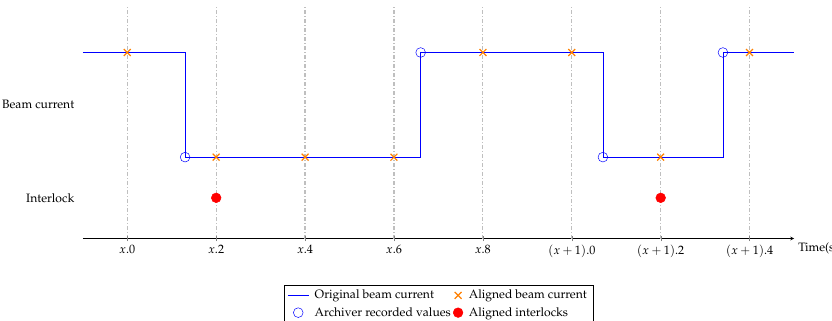
Figure 4. Synchronization of the beam current as an example channel and the